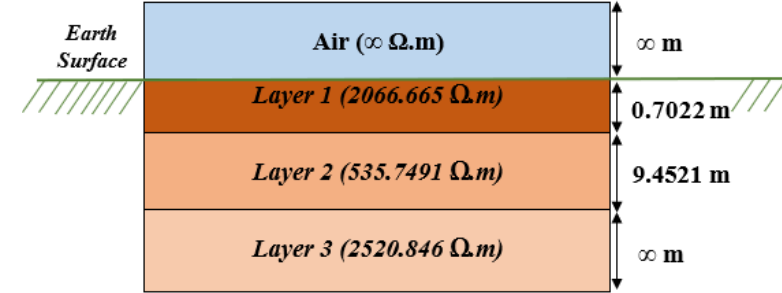
Figure 9. Soil profile interpretation for the Tower T48.